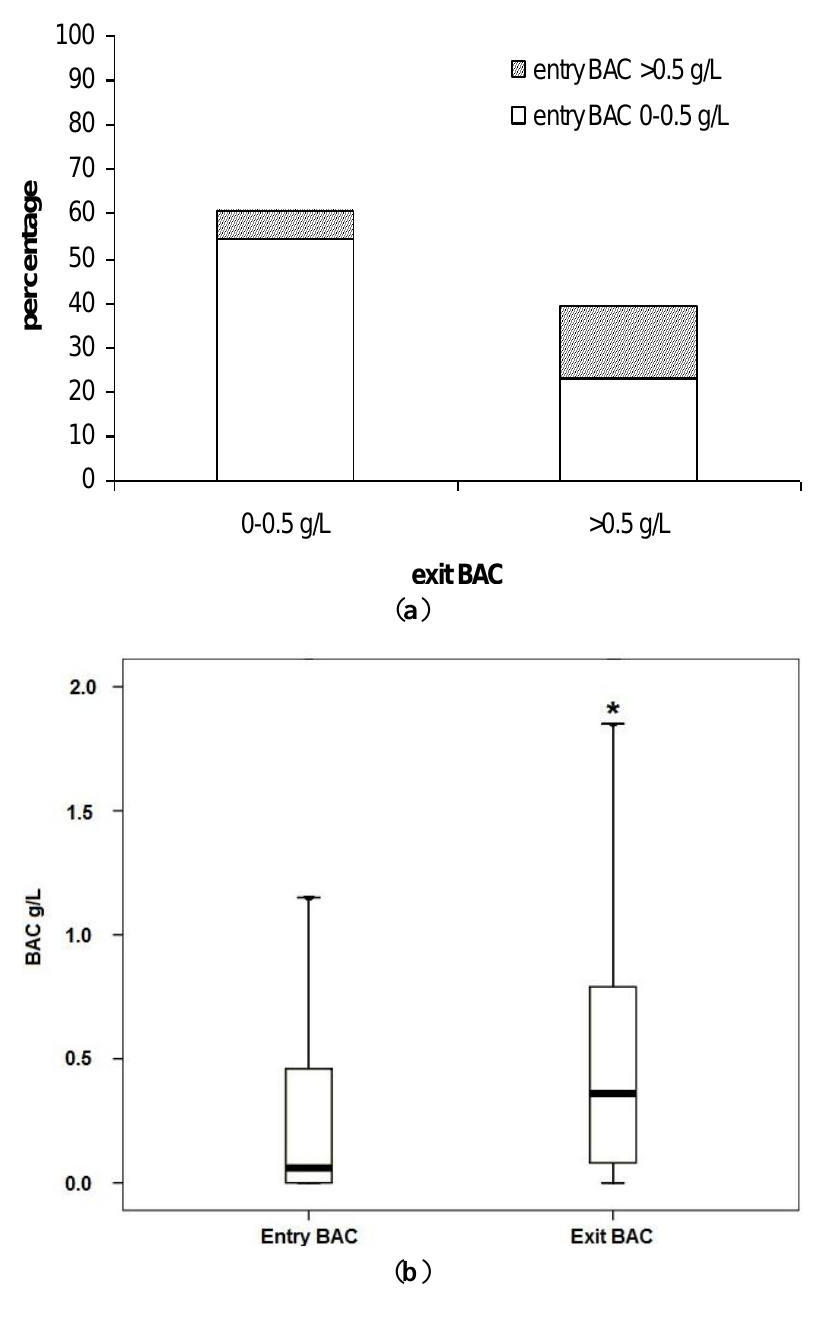
Figure 1. Comparisons of BAC values measured at the same people at the entry to the clubs and at the exit from them and box plot of BAC value at entry to the clubs and at exit from them (delta value: 0.24 g/L; * p <